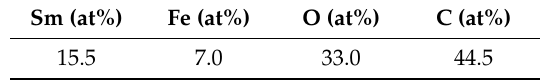
Figure 4. Survey of the SmFeO 3 powder with the peak assignment.